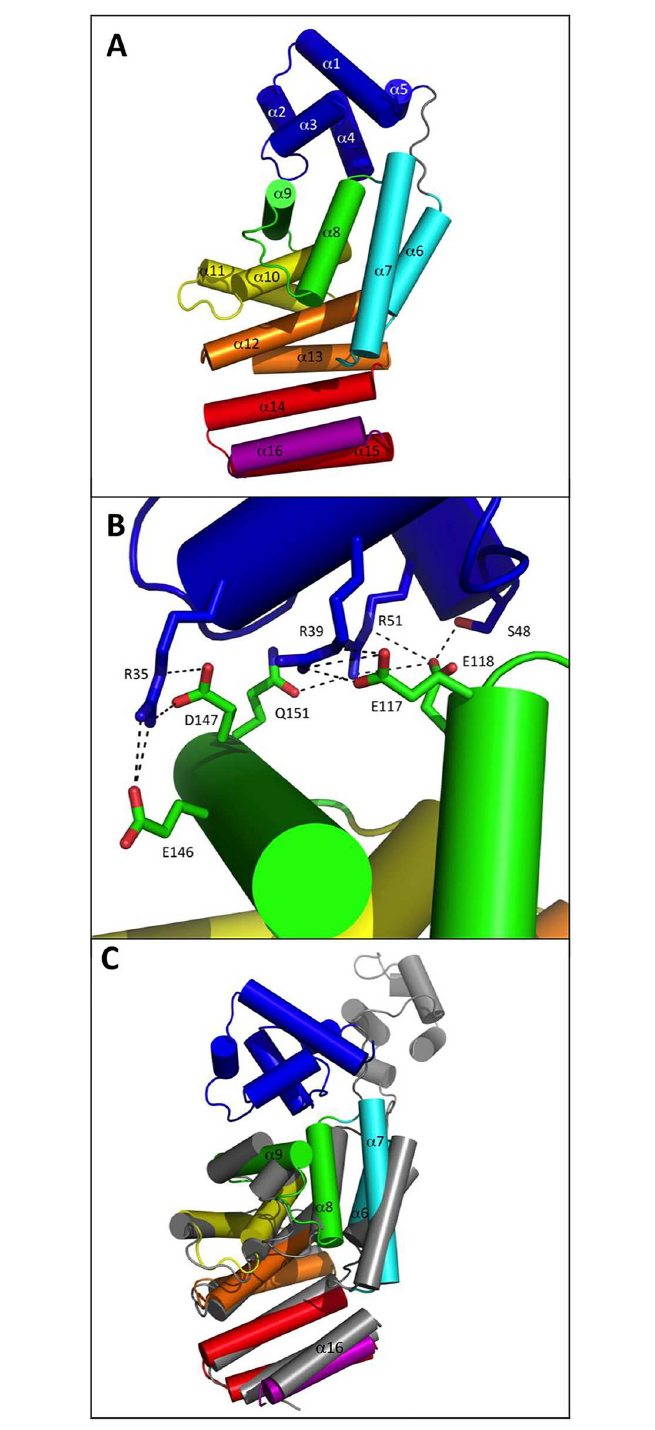
Fig 4. Apo conformation of ComR. A–Overall view of the monomeric apo state. ComR is shown as cartoon colored by spectrum from TPR-1 in cyan to TPR-5 in red with the additionalCAP helix α 16 in purple and the HTH-domainin blue. The α -helicesare labeled. B–Close view of the HTH sequestration mode. The protein is shown as cartoon colored by spectrum as in panel A with the contact residueshighlightedin sticks, colored by atom type and labeled. C–Superimposition of the free and bound forms of the TPR domain. Superimposition of the apo structure of ComR, coloredby spectrum, and chain B from the ComR/ XIP/DNA dimer, shown in